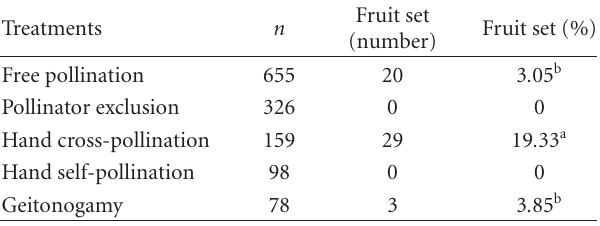
Table 1: Initial fruit set of Brazil nut ( Bertholletia excelsa ) flowers submitted to five pollination treatments: open pollination, bagged with muslin bags, hand cross-pollination, hand self-pollination, and geitonogamy. Itacoatiara, Amazonas, Brazil,